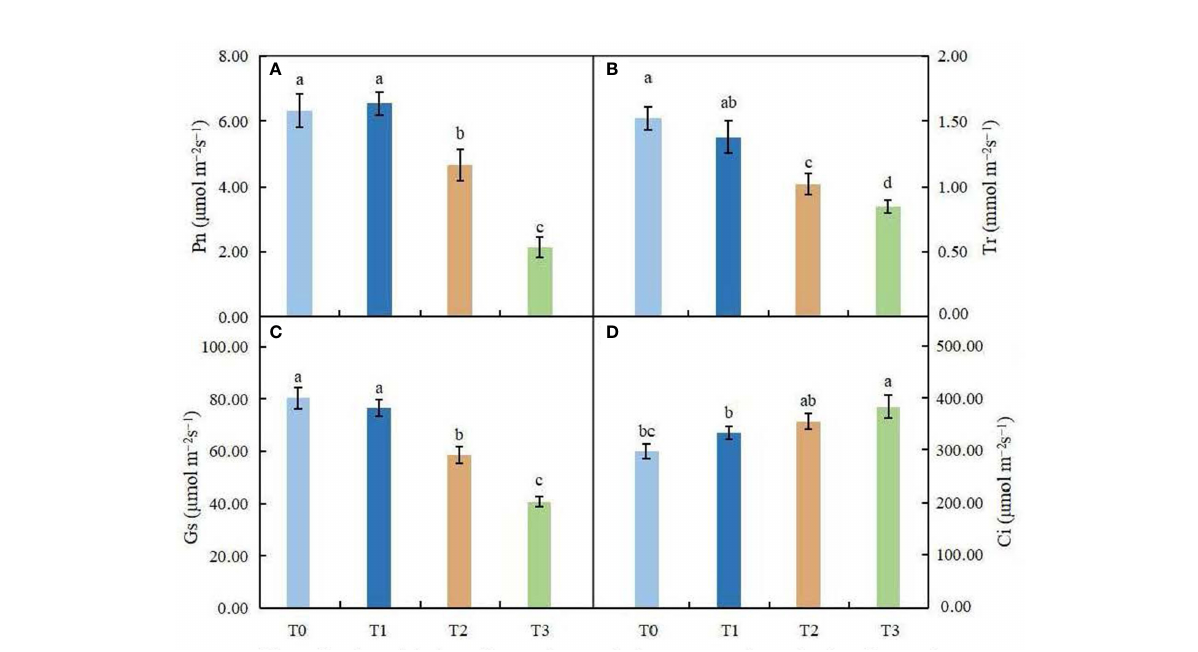
FIGURE 3 Effects of various light intensities on photosynthesis parameters in C. betulus after 60 days. Pn , net photosynthetic rate (A) ; Tr , transpiration rate (B) ; Gs , stomatal conductance (C) ; Ci , intercellular CO 2 concentration (D) . Different lowercase letters indicate signi fi cant differences between treatments ( P < 0.05), n =